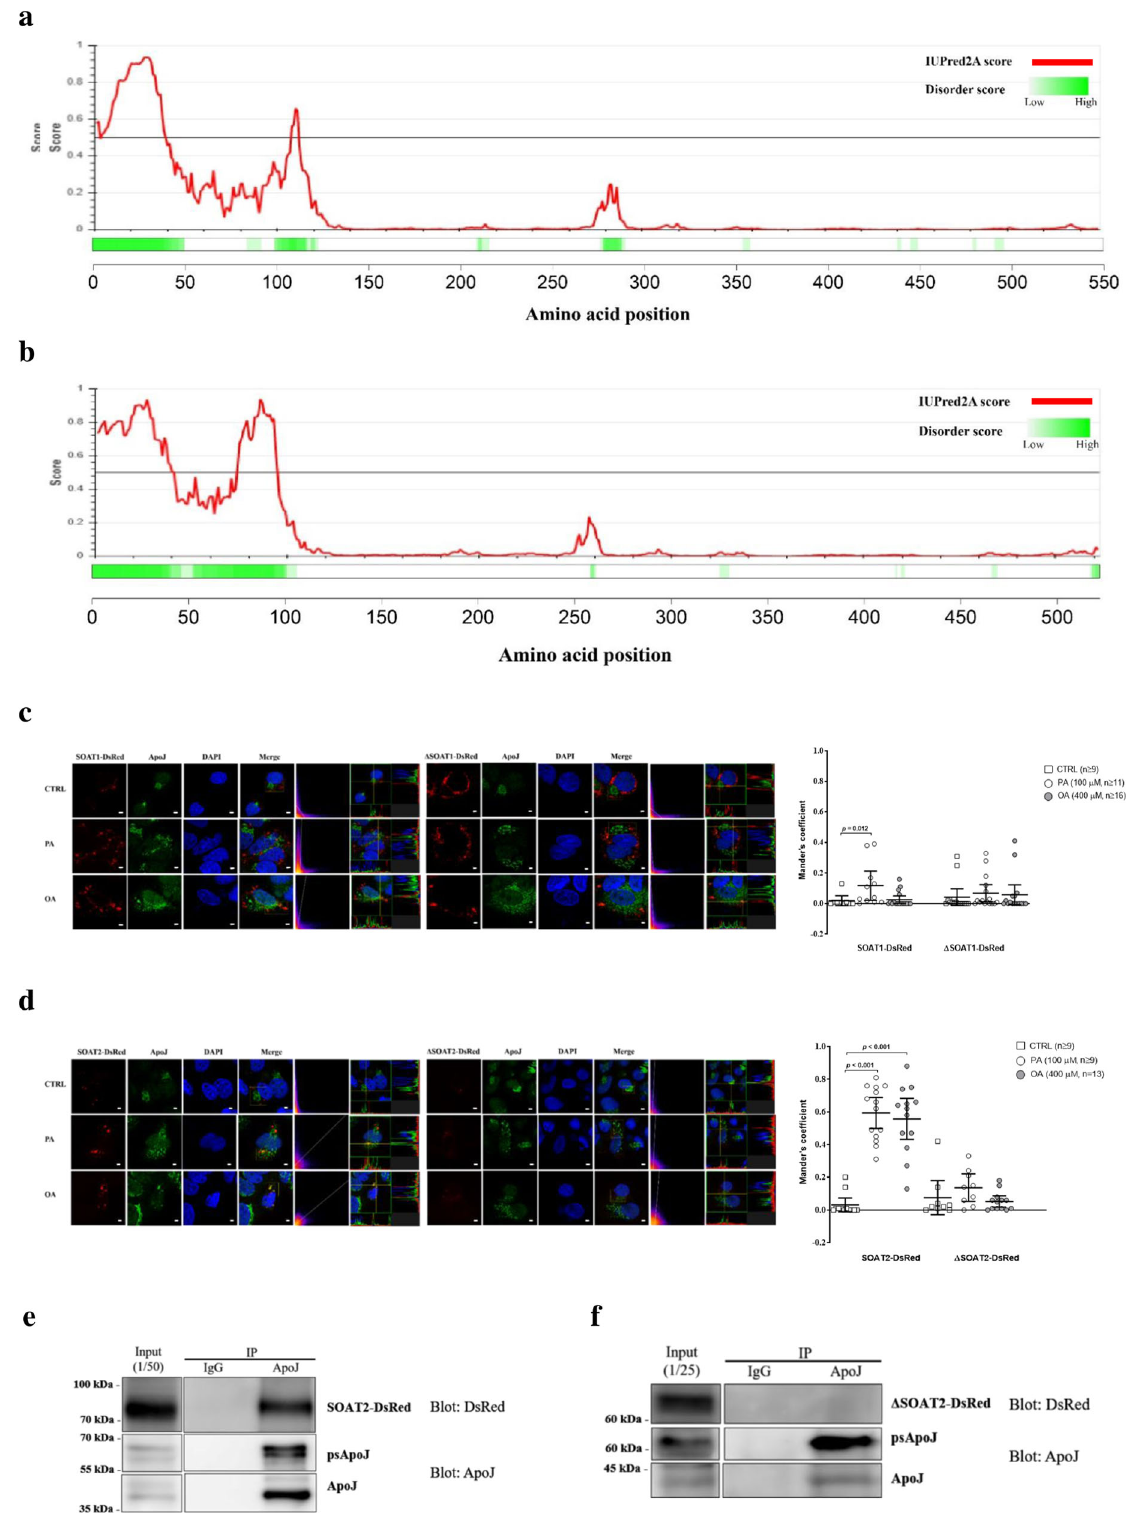
Fig. 5 ApoJ co-localized with SOAT2 by recognizing the IDR region. The IDR regions of SOAT1 (UniProt ID: P35610, a ) and SOAT2 (UniProt ID: O75908, b ) were predicted by D 2 P 2 (http://d2p2.pro/search) and IUPred2A (https://iupred2a.elte.hu/) algorithms, respectively. Huh7 cells were transfected with SOAT1-DsRed ( c , the left panels), IDR-truncated SOAT1-DsRed ( Δ SOAT1-DsRed, c , the right panels); SOAT2-DsRed ( d , the left panels), and IDR- truncated SOAT2-DsRed ( Δ SOAT2-DsRed, d the right panels), followed by administration of PA (100 μ M) or OA (400 μ M) for 24 h, and visualized with confocal microscopy. The fl uorescence intensity was analysed by FVW31S software. The Mander ’ s coef fi cient was analysed by ImageJ with the Coloc2 plugin from ImageJ/Fiji shown above. Scale bar, 5 μ m. Huh7 cells were transfected with plasmids encoding SOAT2-DsRed ( e ) or Δ SOAT2-DsRed ( f ). The cell lysates were immunoprecipitated with antibody against ApoJ and examined by western blot analysis recognizing DsRed and apoJ.